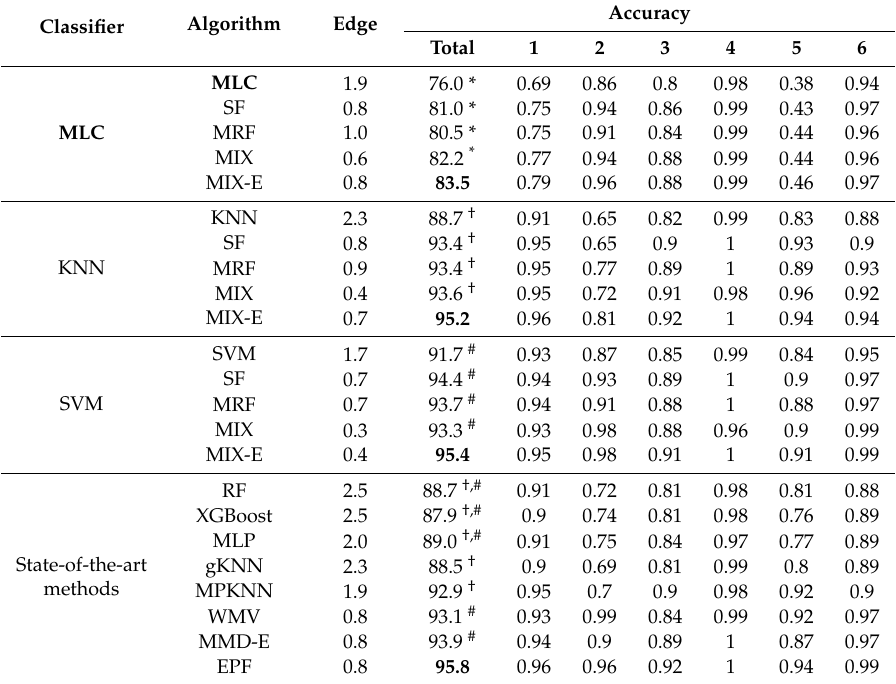
Table 3. Overall accuracy (%), F1-score per class, and edge index of classification results for the IKONOS dataset.